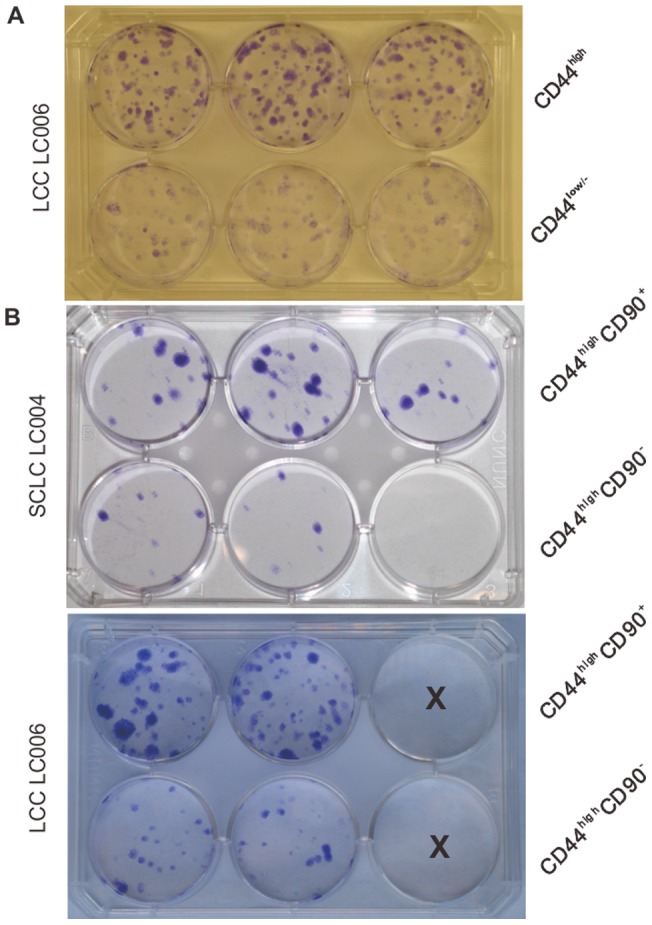
Comparison of colony forming potential of different cell sub-populations from PLCCLs by colony formation efficiency assays.
A. Comparison of FACS sorted CD44high and CD44low/− cells from the LCC cell line LC006. Cells were seeded at 200 cells per well and grown in standard 6 well plates for ∼10 days. Upper wells: CD44high cells. Lower wells: CD44low/− cells. B. Comparison of FACS sorted CD44highCD90+ and CD44highCD90− cells from the SCLC cell line LC004 (upper plate) and the LCC cell line LC006 (lower plate). Cells were seeded at 200 cells per well and grown in standard 6 well plates for ∼10 days. In each 6-well plate: upper wells: CD44highCD90+ cells; lower wells: CD44highCD90− cells. X denotes empty wells.